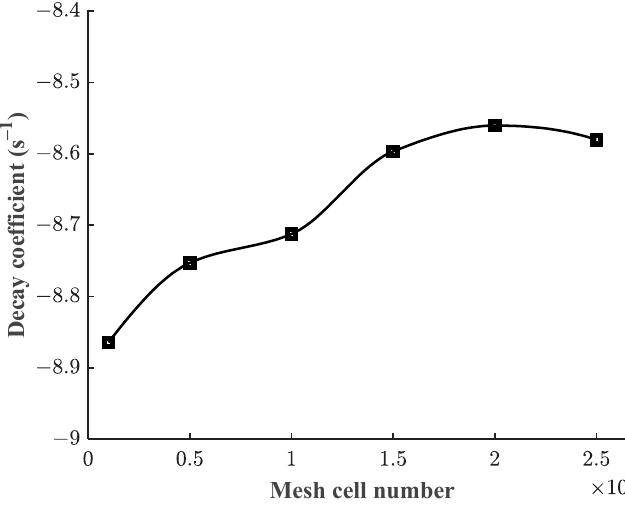
Figure 4. The decay coefficient under different mesh cell number.